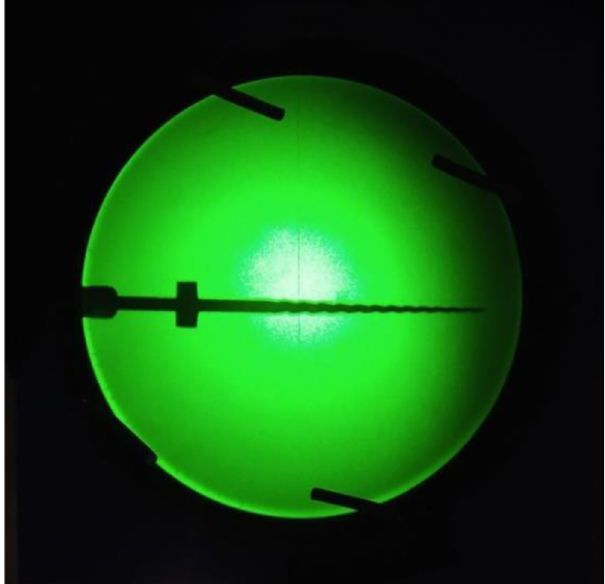
Fig. 1. Endodontic fi le pro fi le view obtained on optical pro fi le meter.